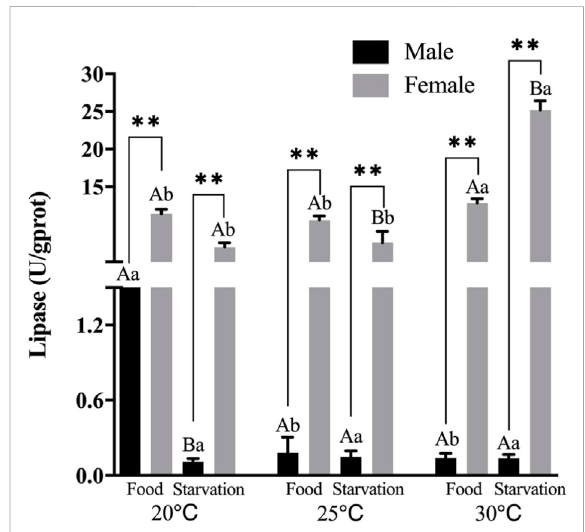
FIGURE 2 Lipase (LPS) of different sex M. coruscus exposed to six combinations of temperature (20, 25, and 30 ° C) and the feeding condition (food and starvation) at 30 days during the exposure period.Differentcapitallettersindicatesigni fi cantdifferences between the feeding condition and each temperature levels (20, 25, and 30 ° C) ( p < 0.05). Different small letters indicate signi fi cant differences between temperature (20, 25, and 30 ° C) and the same feeding condition ( p < 0.05). Asterisk indicates signi fi cant differences between sex and each feeding condition, in which * representssigni fi cantdifference( p < 0.05)and**representshighly signi fi cant difference ( p < 0.01).